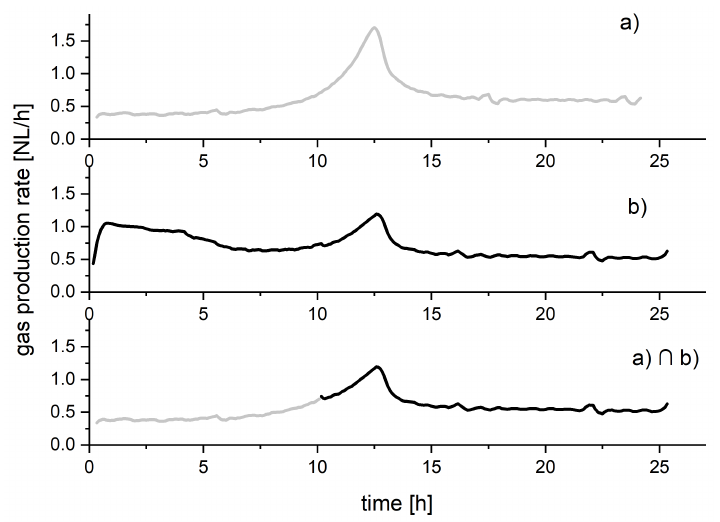
Figure 2. Course of the gas production rate after feeding the reactor with glycerin ( a ) and after feeding with a sewage sludge sample spiked with glycerin ( b ). The diagram below shows the intersection of ( a ) and ( b